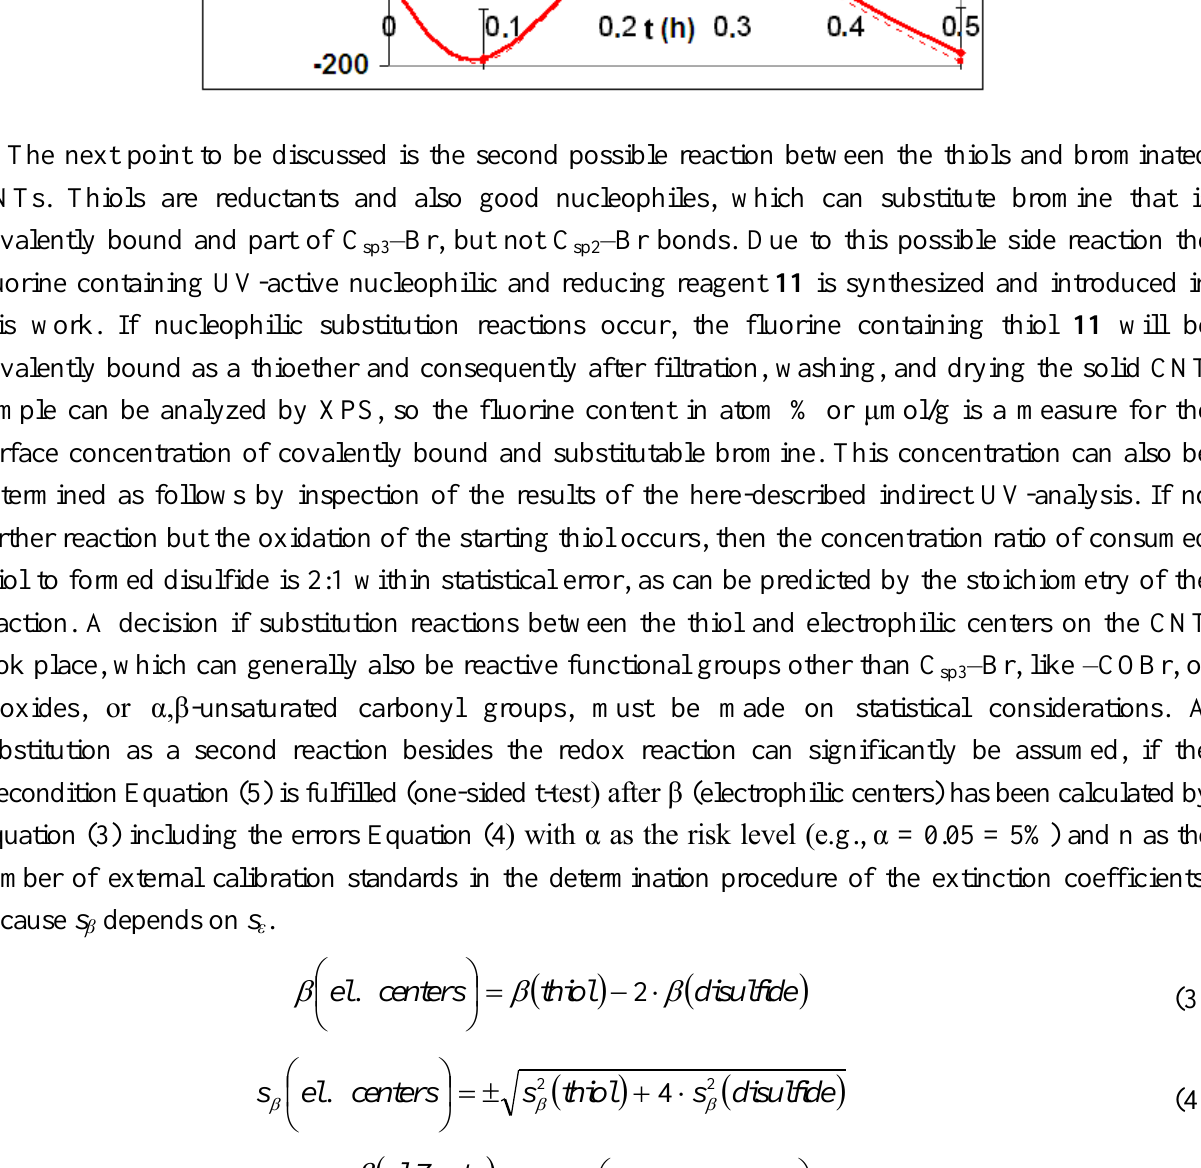
Figure 10. Reaction R3 comparison c